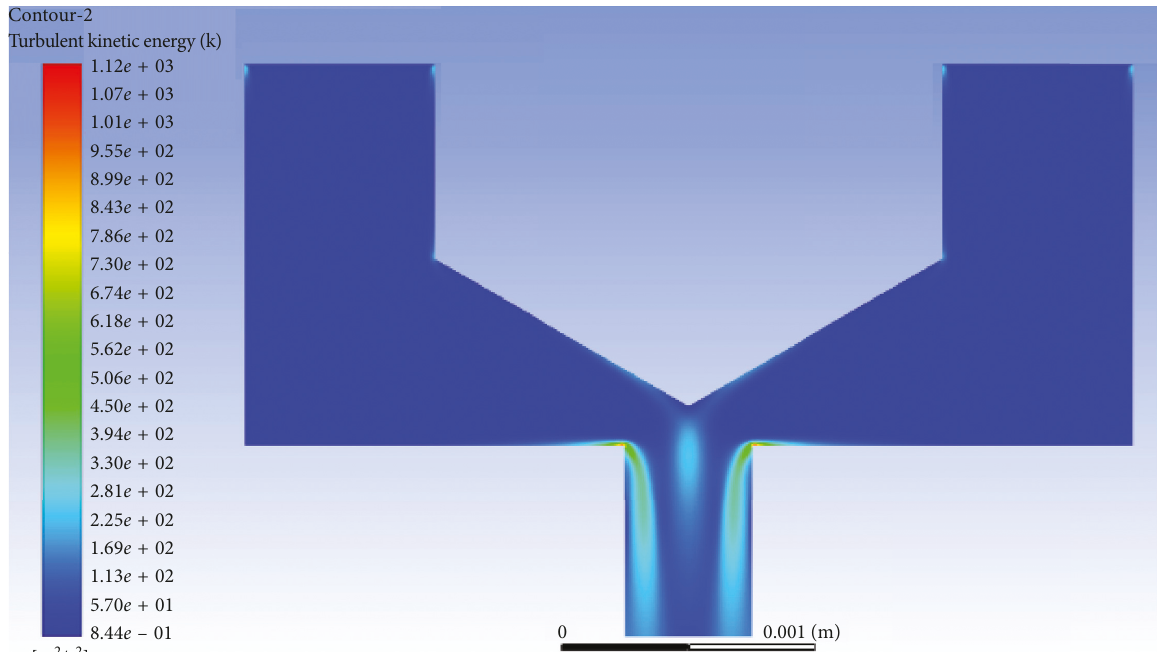
Figure 33: Turbulent kinetic energy distribution nephogram (120 ° ).